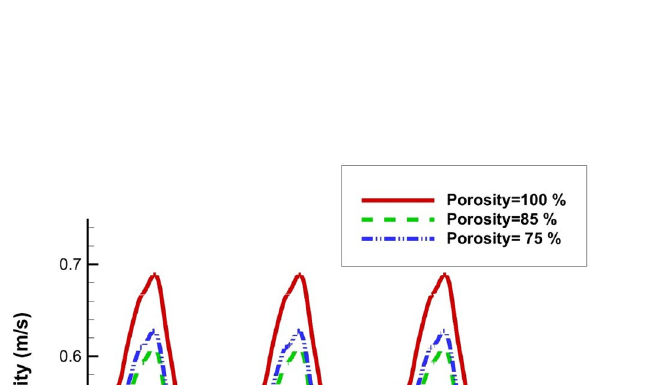
Figure 11. Influence of coiling porosity on ( a ) pressure ( b ) AWSS c) iso-velocity (v = 0.75 m/s) contour at peak systolic.